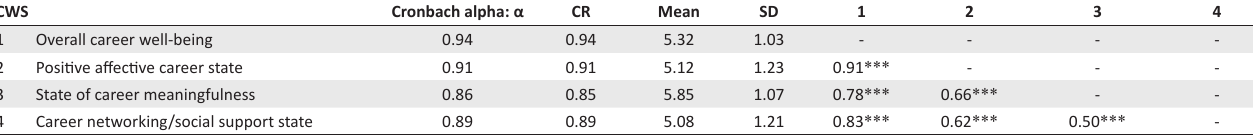
TABLE 1: Descriptive statistics and bi-variate correlations of the Career Wellbeing Scale. CWS